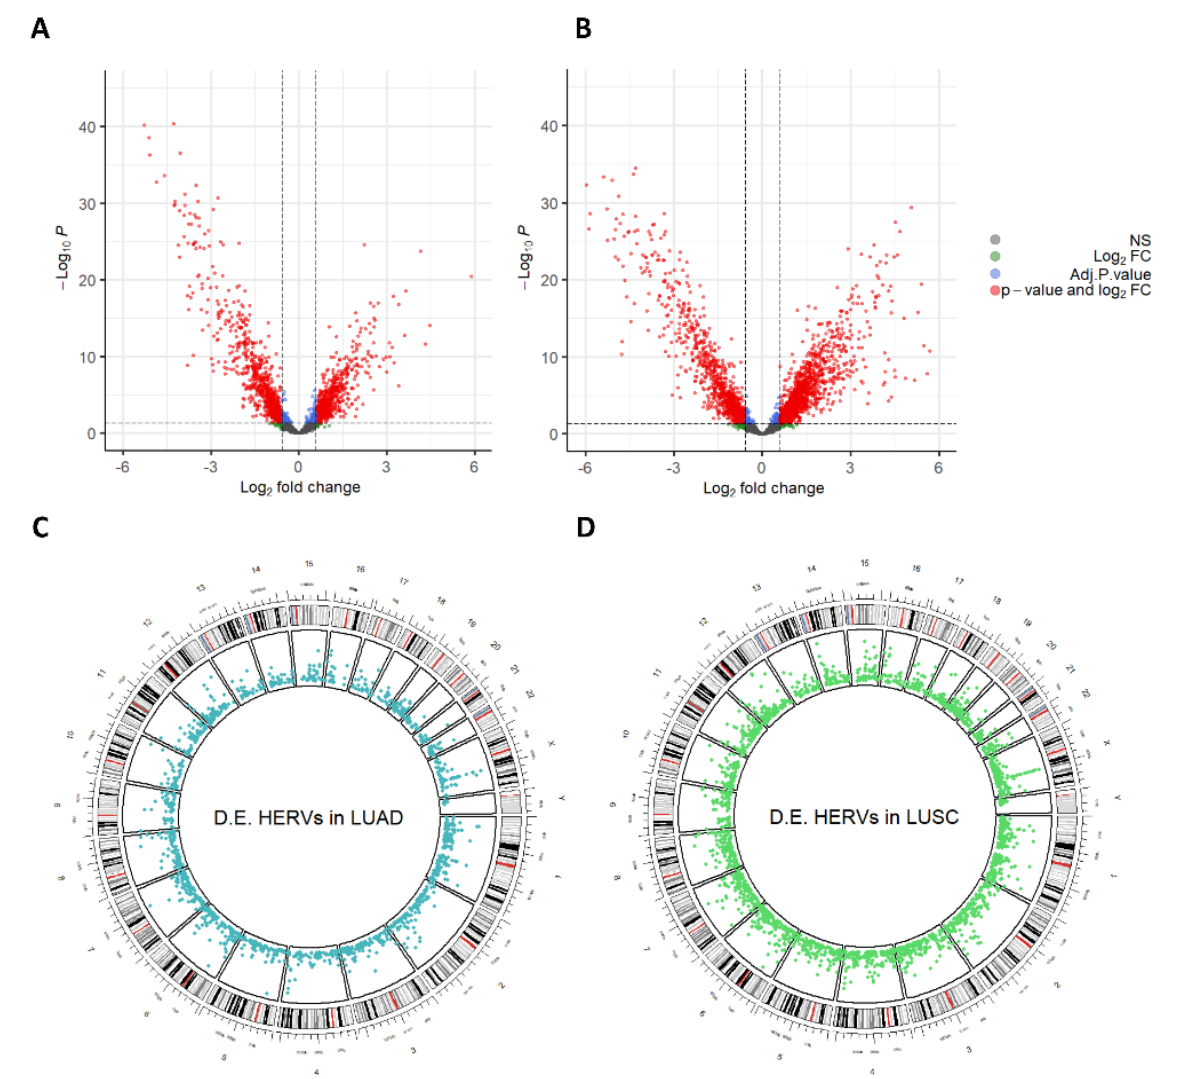
Figure 2. Volcano plots showing the distribution of the differentially expressed HERVs (red) identified in TCGA − LUAD ( A ) and TCGA − LUSC ( B ) in a two-dimensional space where the Y-axis is the significance ( − Log 10 P.value) and the X-axis is the magnitude of the change (Log 2 FC); Circos plots showing the distribution of the differentially expressed HERVs identified in TCGA − LUAD ( C ) and TCGA − LUSC ( D ) across all human chromosomes.